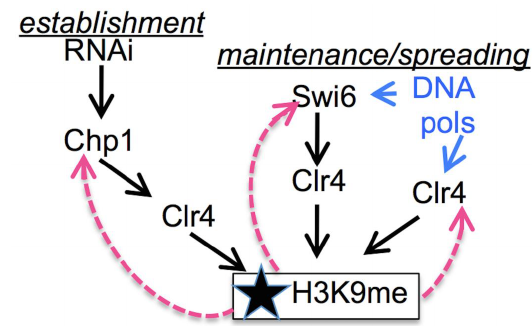
Figure 2. Multiple pathways contribute to the establishment and maintenance of H3K9 methylation. Pink dashed arrows indicate the binding of chromodomain-containing proteins to H3K9me. Both Swi6 and Clr4 bind DNA